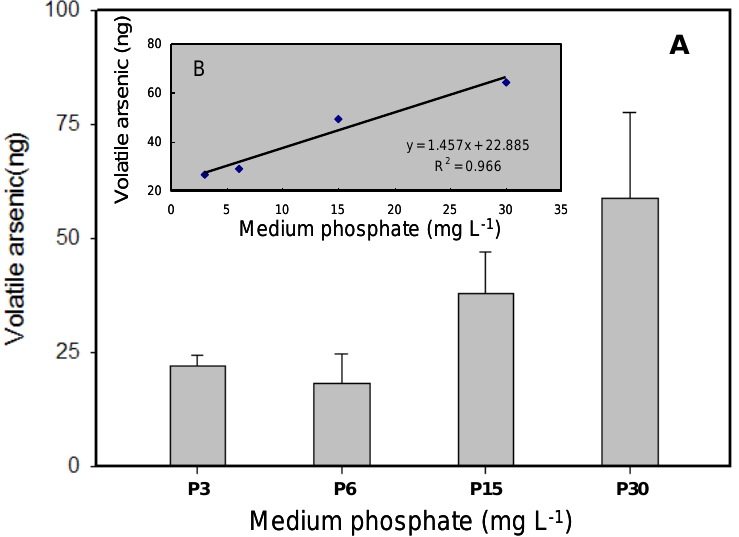
Figure 6. Volatile As level produced by T. pyriformis. ( A ) Exposure to 40 μM As(V) for 20 h under different P concentrations; ( B ) The relationship between volatile As and the initial P levels. All data are mean ± SE ( n = 4).